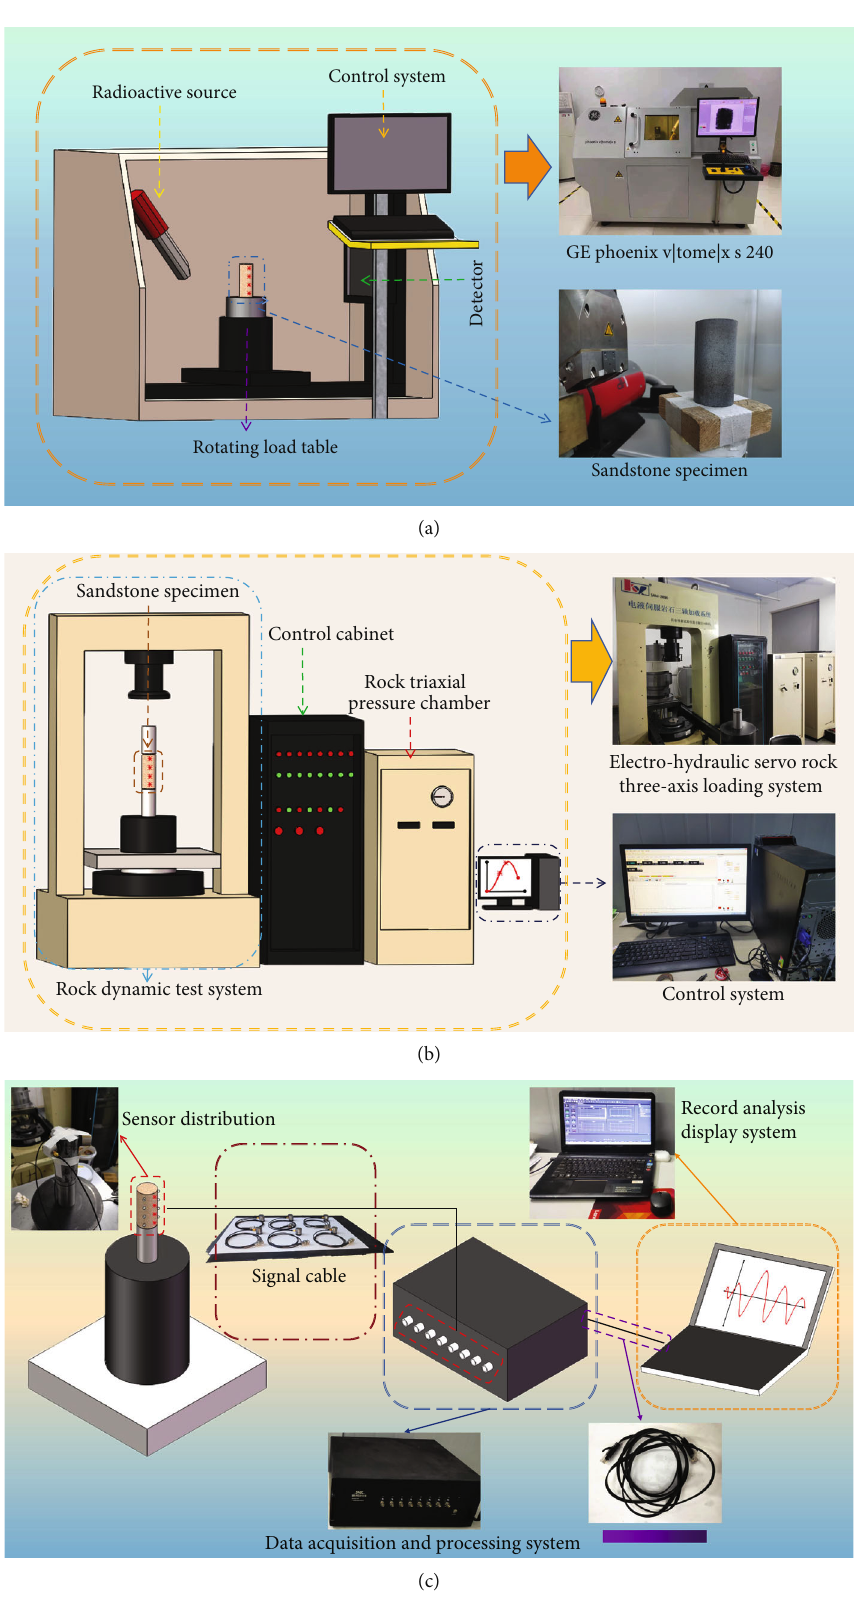
Figure 1: Test equipment. (a) GE phoenix v|tome|x s240. (b) SAM-2000 electro-hydraulic servo rock triaxial loading system. (c) PXDAQ24260B acoustic emission